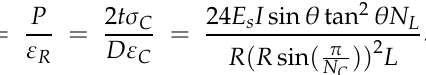
Figure 14. Illustration of force equilibrium relationship between radial direction and circumferential direction.